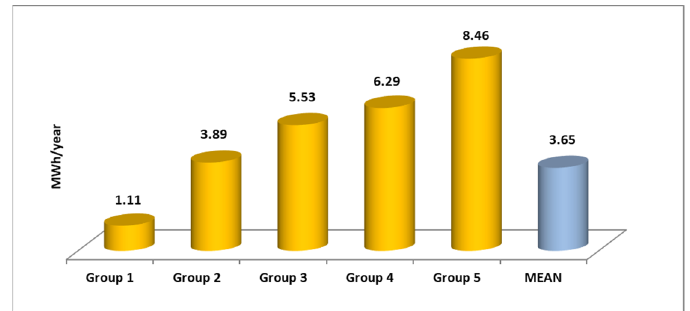
Table 4. Statistical data of household consumption.